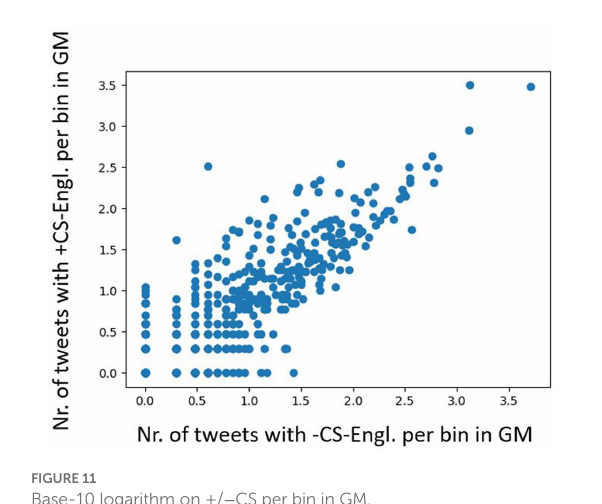
FIGURE 10 +/ − CS-Engl. per urban location in GM.